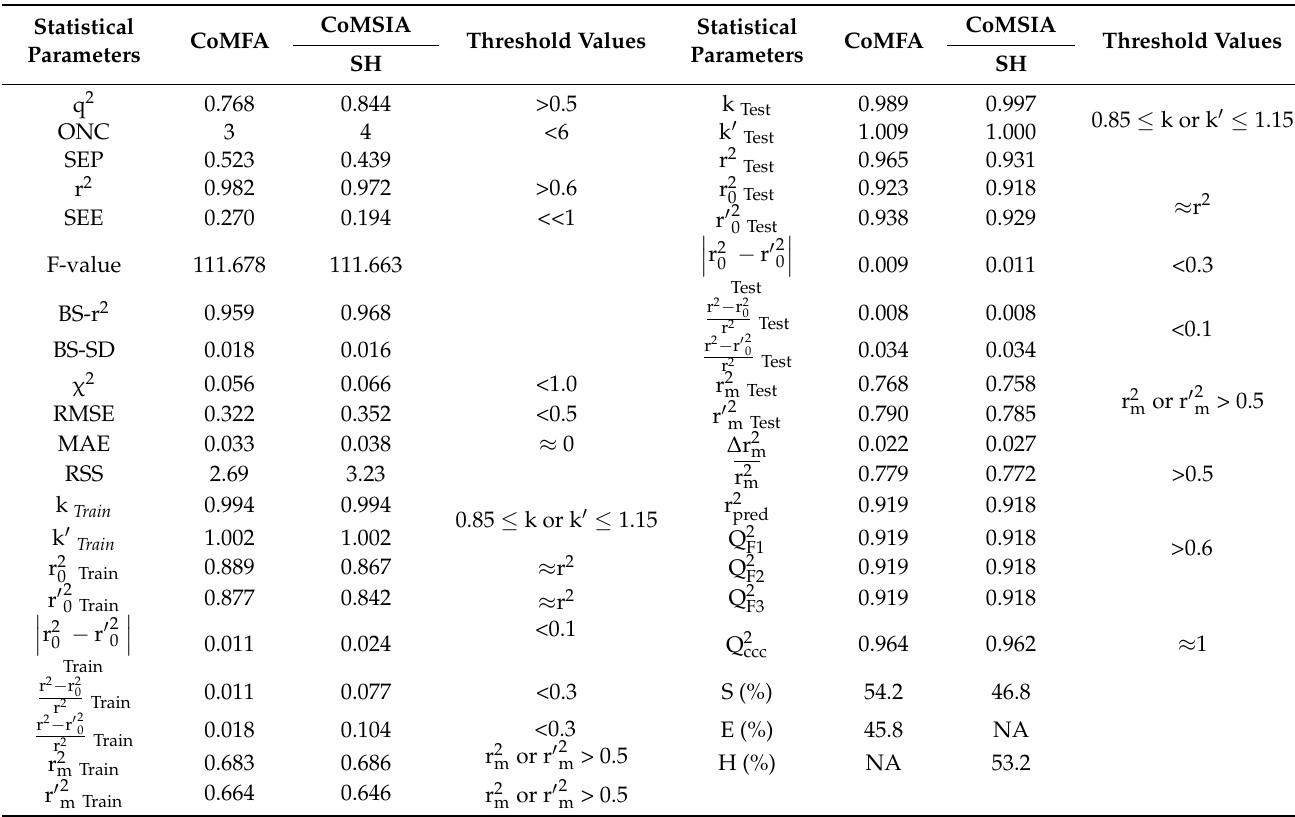
Table 2. Statistical results and validation of CoMFA and CoMSIA